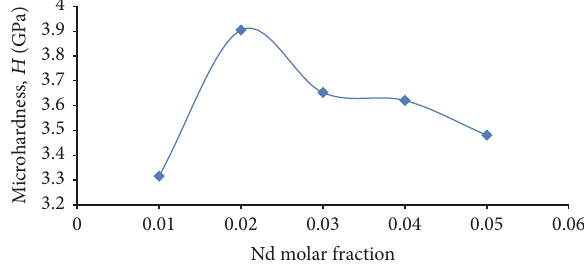
Figure 9: Microhardness of [(TeO 2 ) 0.70 (ZnO) 0.30 ] (1−𝑥) (Nd 2 O 3 NPs) (𝑥) glasses.